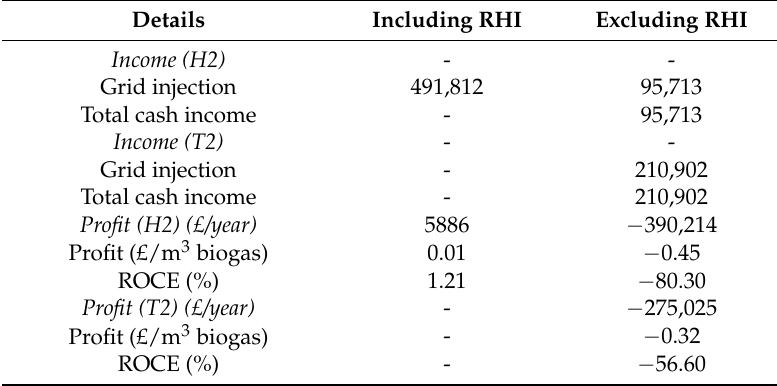
Table A4. Income, profit and ROCE for conventional upgrading of biogas for use as CNG (routes T2/H2).